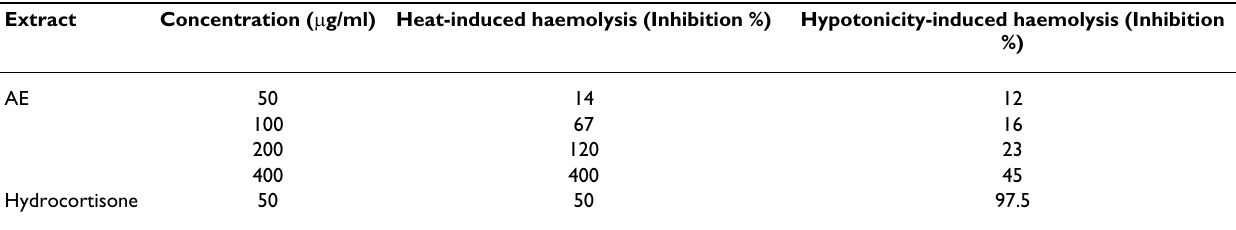
Table 6: Effect of extract on heat- and hypotonicity-induced haemolysis of red blood cells